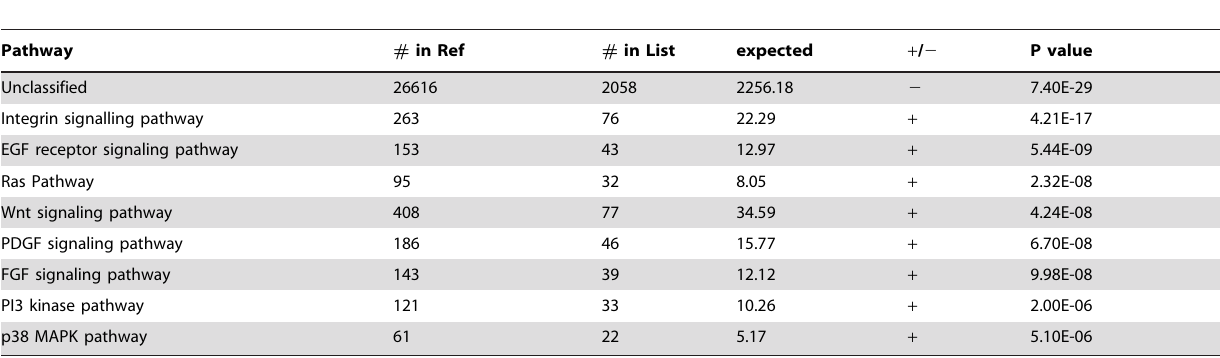
Table 1. Predicted target genes (using TargetScan) for candidate miRNAs involved in trophectoderm specification were classified by gene ontology.